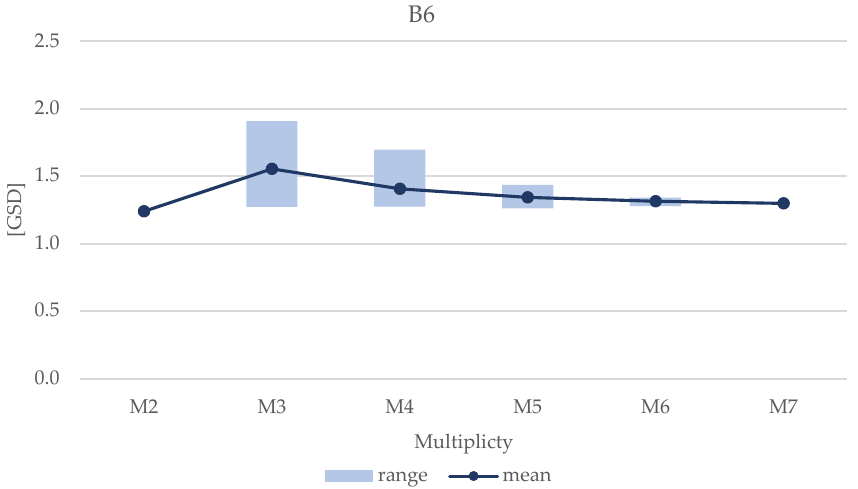
Figure 11. Graphs showing the standard deviation variability within each multiplicity grouping (minimum, average and maximum values). The data refer to Site B (Nikon D3).